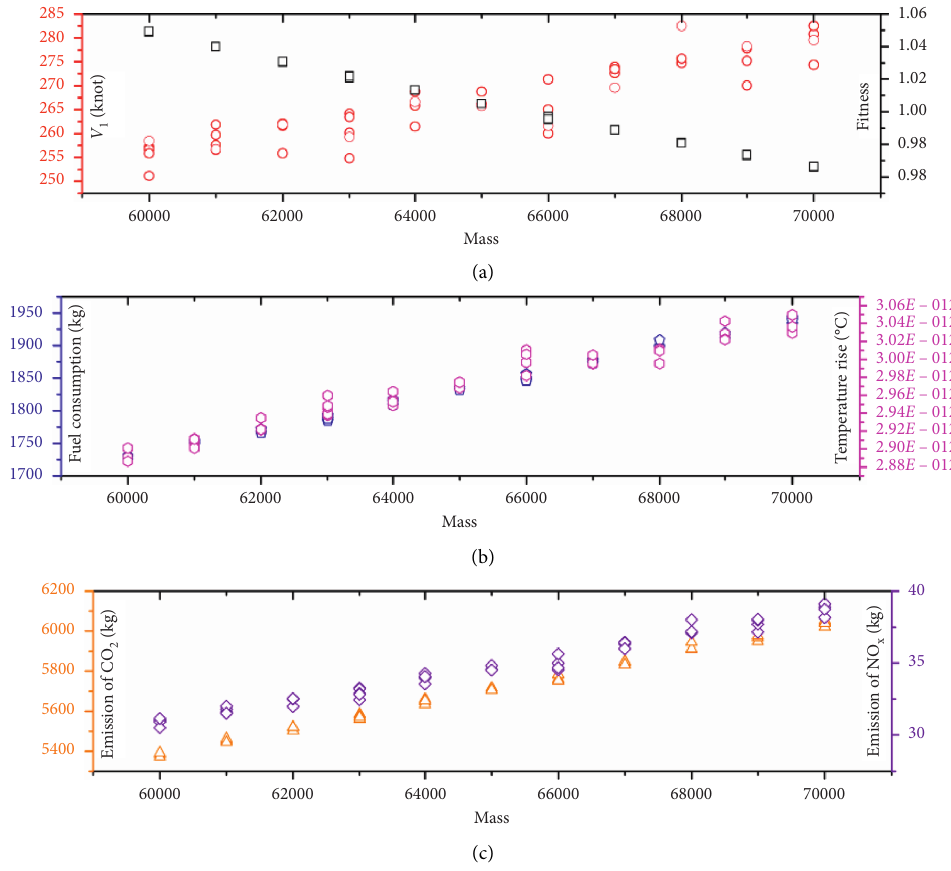
Figure 10: Impact of aircraft mass on optimization results.